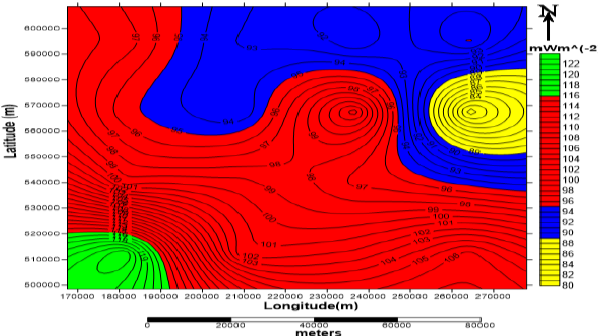
Figure 16: Geothermal gradient contour map of the study area.